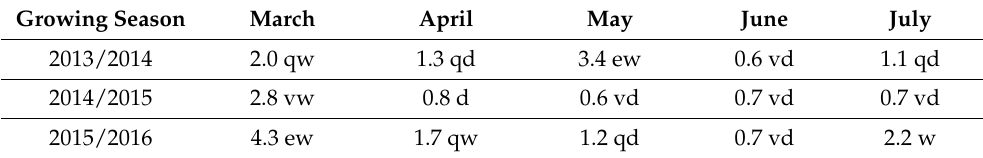
Figure 1. Daily mean air temperature and precipitation at the Experimental Station Smolice during the study. Table 2. Values of the Sielianinov hydrothermal index ( k ) for winter wheat (March–July). Growing